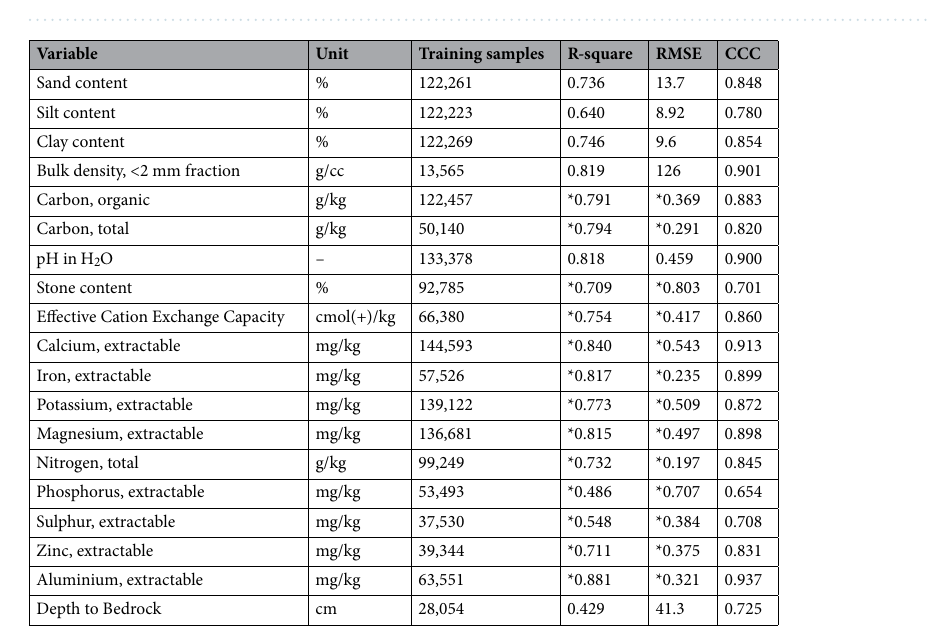
Figure 3. Example of predictions of soil pH 1:1 water suspension at 0 cm ( a ) and 50 cm ( b ) depths whole of Africa. See also Fig. 2. Visualizations produced using QGIS v3.10 (https ://www.qgis.org/).